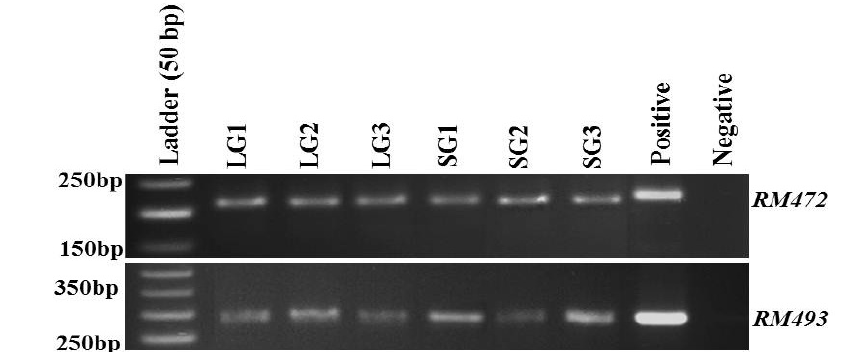
Figure 4: Composite agarose gel image of the simplex PCR with RM472 and RM493 markers (2.5 % agarose gel electrophoresis). The names of the microsatellite markers are indicated on the right side of the Figure and the key band sizes of the ladder are indicated on the left side. The 50bp ladder was used as the size standard. Names of the market samples are given on the top. Three long grain (LG) (Nadu) and three short grain (SG) (Samba) samples were used for the analysis. The leaf DNA of the rice variety At 353 was used as the positive control in simplex